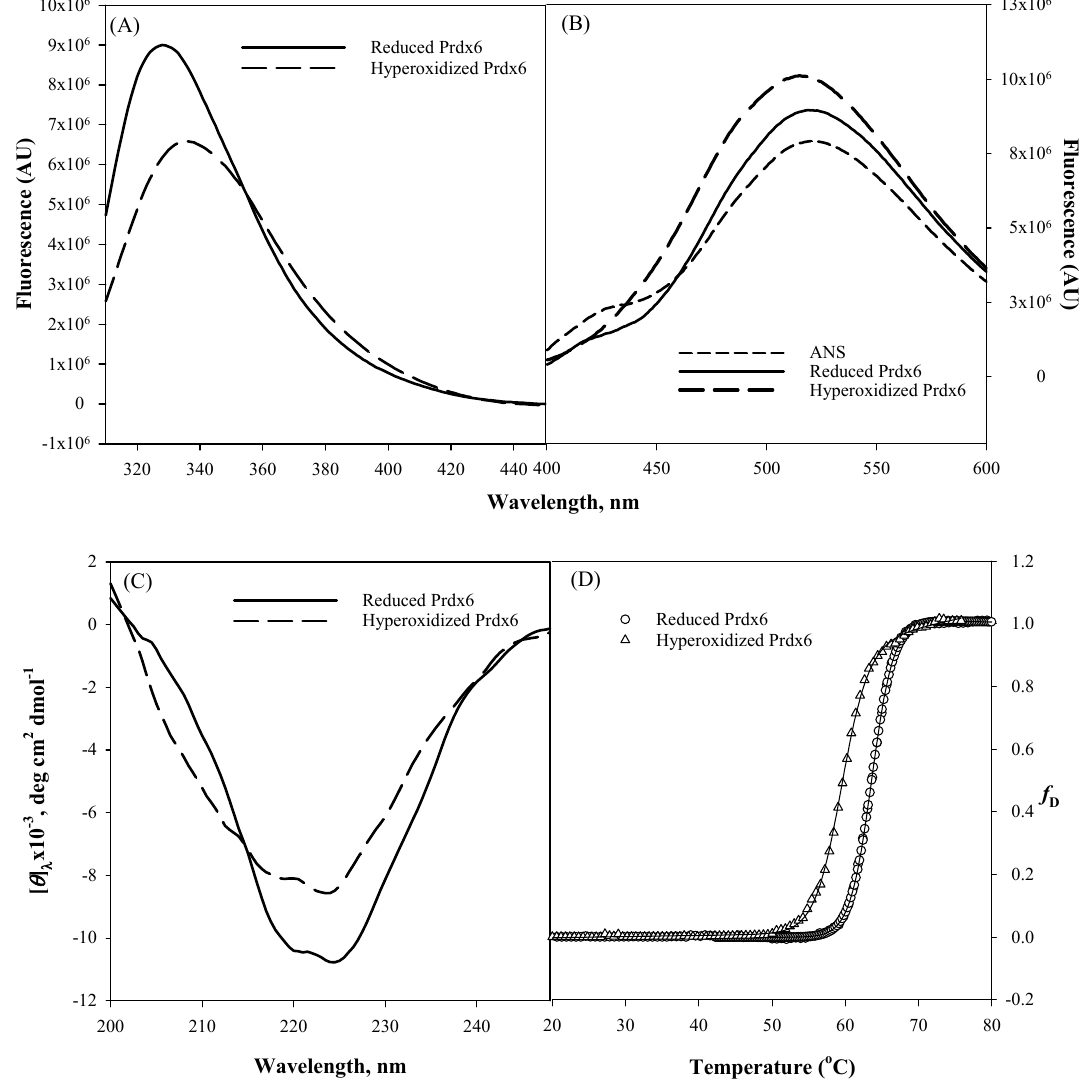
Figure 2. Tryptophan fluorescence ( A ), 8-Anilinonaphthalene-1-sulfonate (ANS) fluorescence ( B ), Far-Ultraviolet (UV) Circular Dichroism CD ( C ) measurements, and normalized thermal-induced denaturation curves ( D ) of reduced Prdx6 and hyperoxidized Prdx6. All measurements were done at pH 7.4 (50 mM Tris-HCl, 100 mM NaCl) and at 25 °C. Thermal denaturation was recorded following changes in [ θ ] 220 from 20 °C to 80 °C at a rate of 1 °C/min. All spectra are the mean of three independent experiments.